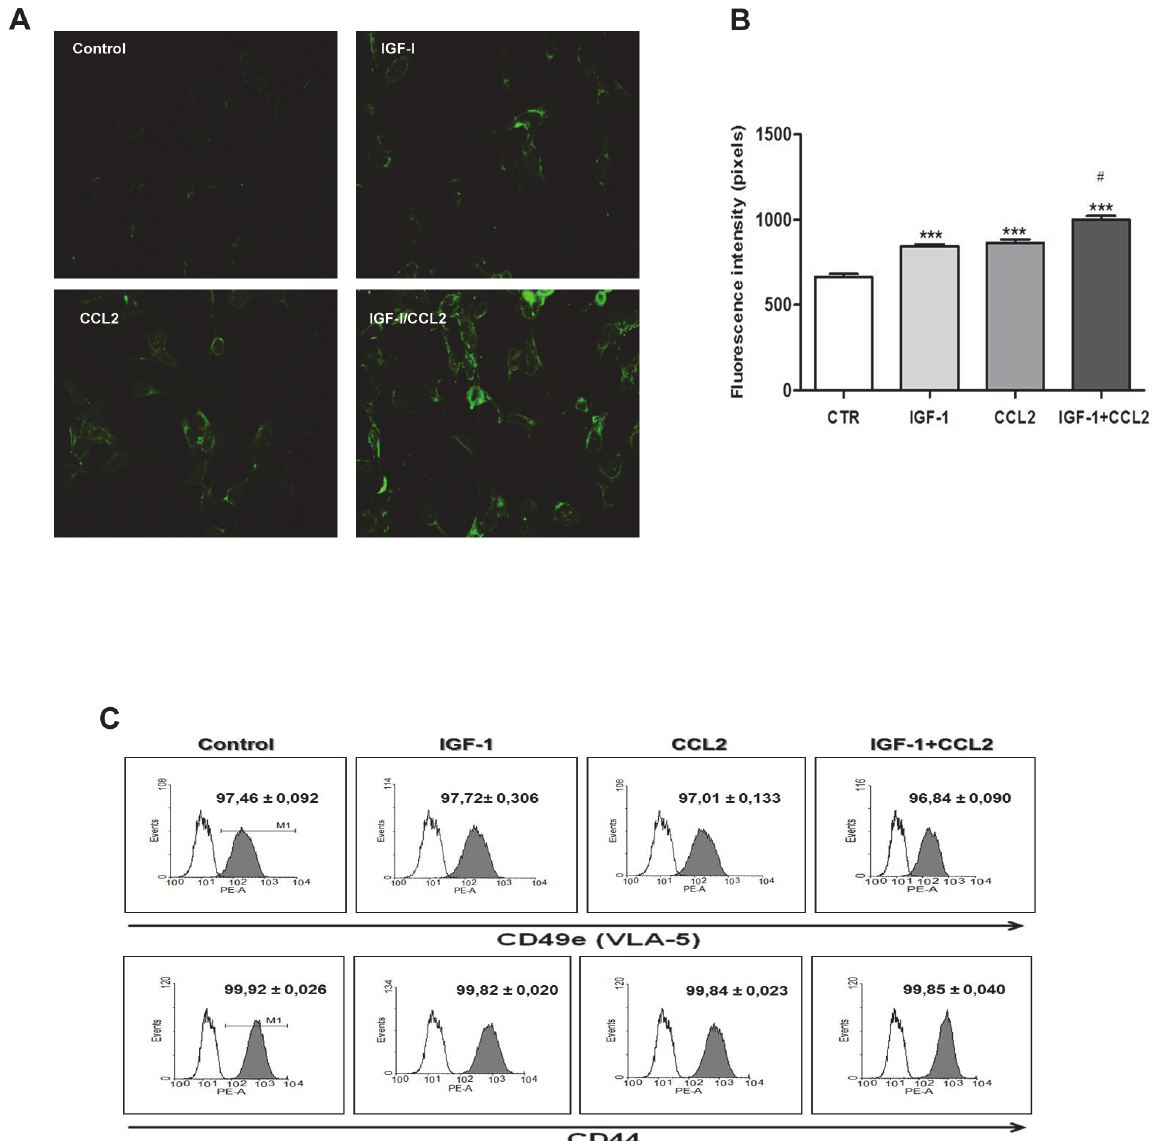
Fig 2. IGF-1 and/or CCL2 augmented fibronectin deposition in tEnd.1 cells. tEnd.1 cells were treated with IGF-1 (100 ng/mL), CCL2 (10 ng/mL), or a combination of both for 24 h and analyzed by fluorescence microscopy. ( A ) Photomicrographs show the expression of FN ascertained by immunofluorescence and fluorescence microscopy analysis. Magnification: 400× ( B ) Bars correspond to the quantitative analysis of FN expression in tEnd.1 cells in selected microscopic fields (n = 5/group). The results are expressed in pixels/ μ m 2 . ( C ) Flow cytometry results are presented as histograms of the average percentage of cells that expressed CD49e/VLA-5 and CD44 receptors for FN (gray) and immunoglobulin control. Values and bars are represented as the mean ± SEM (n = 5/ group). Results were analyzed by one-way ANOVA followed by Bonferroni ’ s post-test. Significant values compared to control group: p < 0.0001 ( *** ); significant values compared to control group and single treatments: p < 0.0001